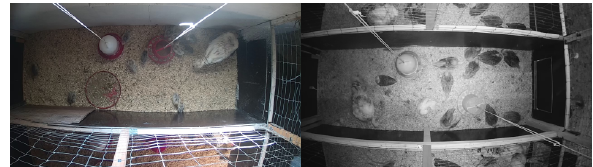
Figure 5. Example of the different colour settings used. RGB video sequence on the left, grey video sequence on the right.